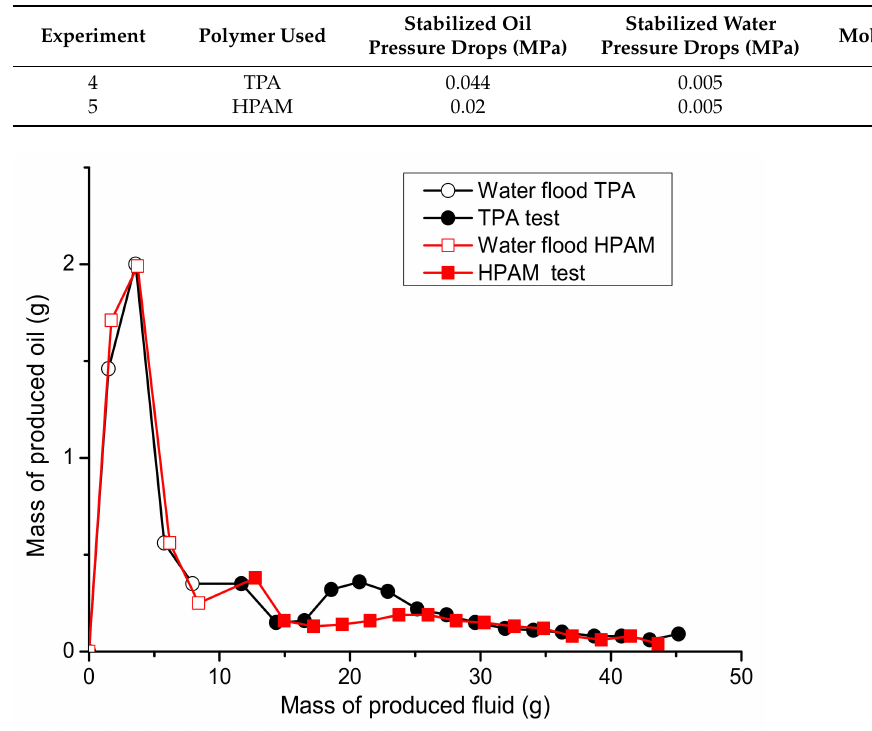
Table 3. Pressure data measured during oil saturation and water flooding.